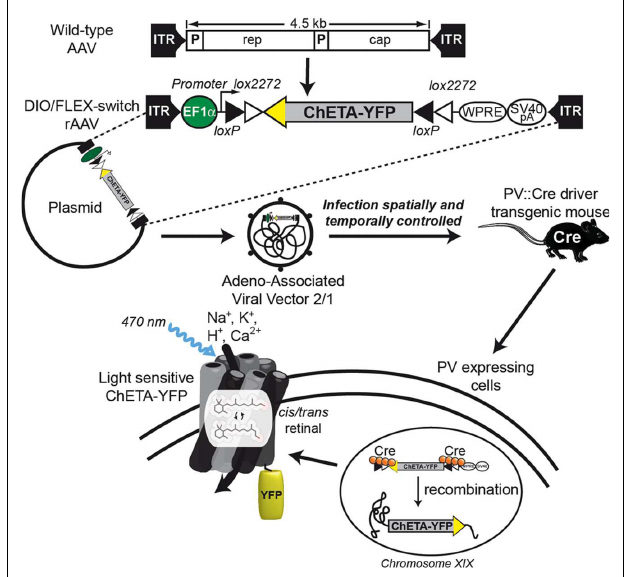
FIGURE 1 | Schematic representation of DIO/FLEX system to express ChETA-EYFP in PV::Cre mouse by rAAV infection. This strategy is based on two components: a Cre-dependant virus containing ChETA-EYFP expression cassette under the control of an ubiquitous EF1 α promoter and a driver transgenic mouse expressing Cre recombinase in neurons containing parvalbumin.The transgene integrates into the host genome allowing stable expression of a fusion protein of ChETA and yellow fluorescent protein